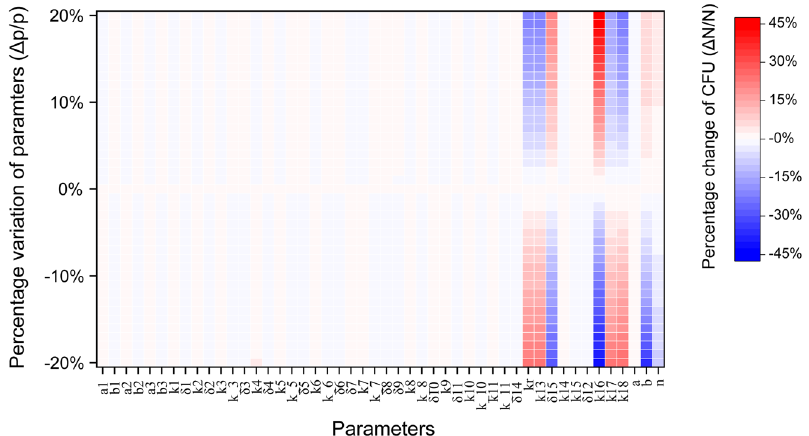
Fig. 9 Sensitivity analysis of all the model parameters. The two-dimensional heatmap represents the corresponding percentage variation of the bacterial density to the percentage change (from − 20% to 20% of the standard value) for each kinetic